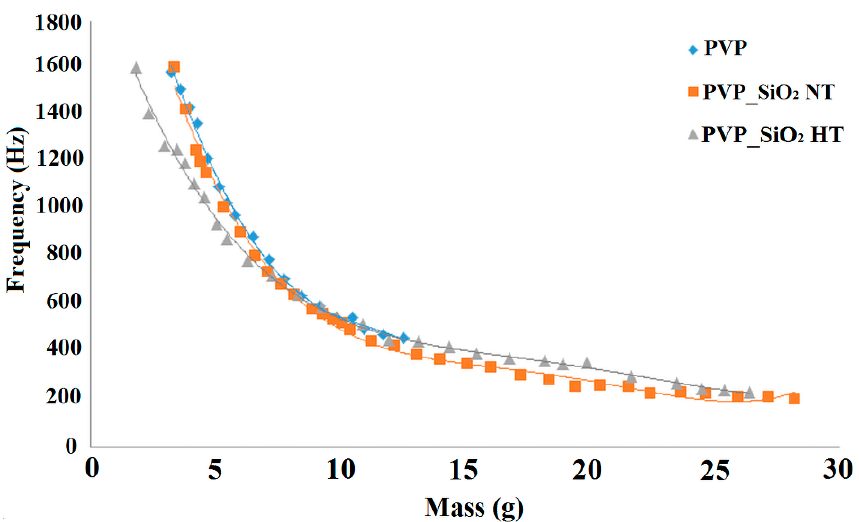
Figure 14. Plots of the frequency of the sound absorption maximum versus the mass per unit surface of the piled disks.